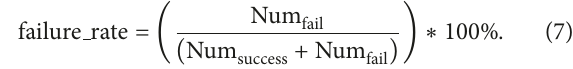
with respect to 𝑚 and 𝑛 SimHash